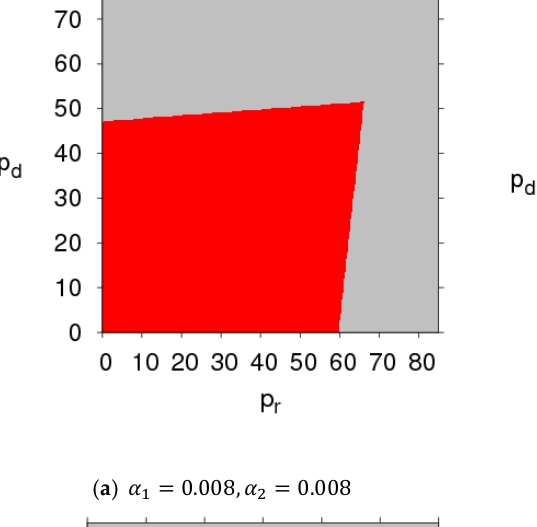
Figure 18. The utility changes of the manufacturer and retailer with respect to 𝛼 1 and 𝜇.